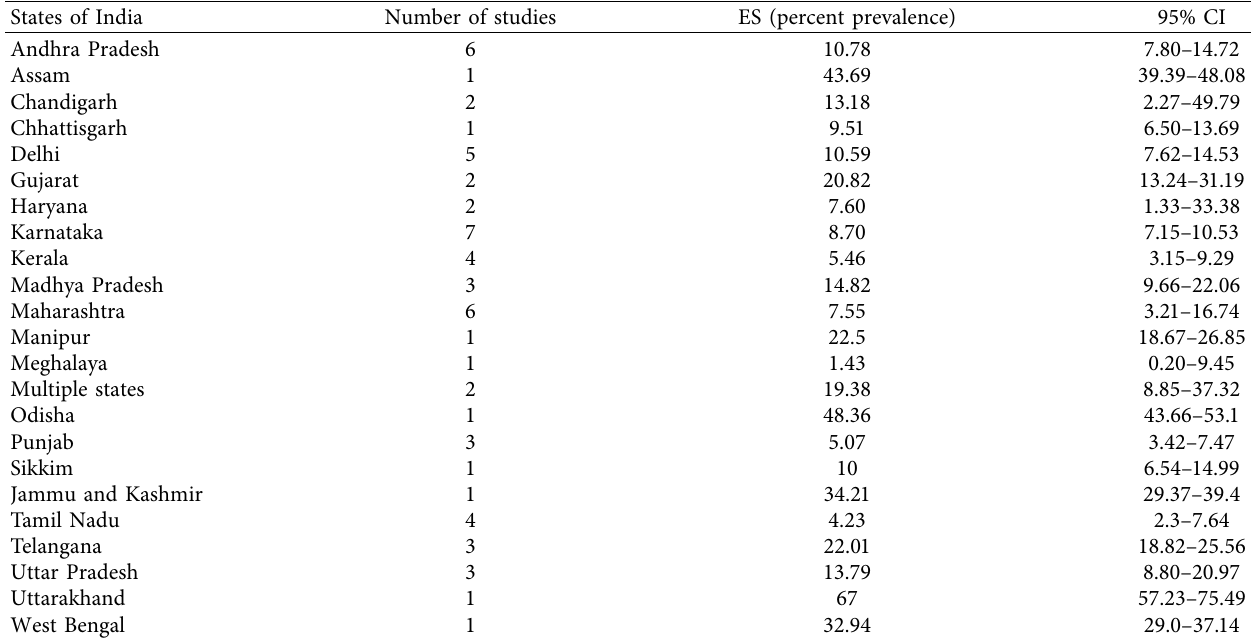
Table 3: Subgroup analysis showing state-wise prevalence (Cochrane Q : 747.87, p value: <